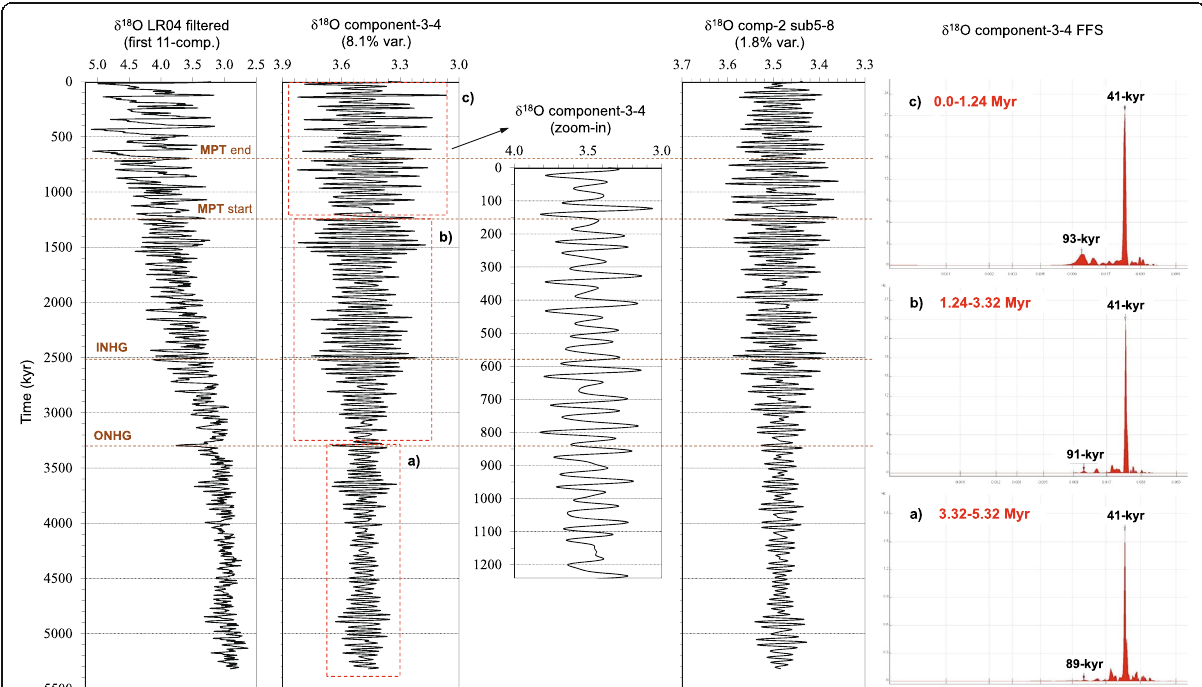
Fig. 4 Time-series panel of the δ 18 O component-3-4 (8.1% var.) and component-2 subcomp-5-8 (1.8% var.) related to obliquity. The Fourier frequency spectrum of component-3-4 in three time intervals is highlighted by red-labeled boxes. The spectrum is always dominated by obliquity 41-kyr power. Note a clear increase in the average 41-kyr amplitude and power towards the beginning of the MPT (box 4a and 4b), followed by an amplitude stabilization and power reduction (box 4c) and an amplitude reduction (comp-2 subcomp-5-8) during the MPT and post-MPT. The envelope of two to three obliquity cycles in a weak eccentricity 93-kyr framework after the beginning of the MPT is noteworthy (box 4c and magnified time series to the right). FFS scale power increases upwards from a to b and decreases from b to c . x -axis scale variable ( ‰ ). Time scale in